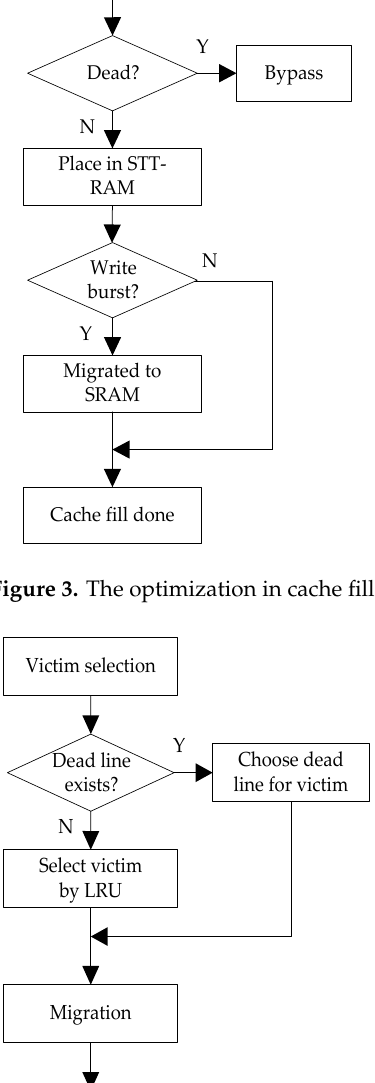
Figure 5. Two classes of migrations. ( a ) Migrations in L2 cache, and ( b ) migrations in L3 cache.